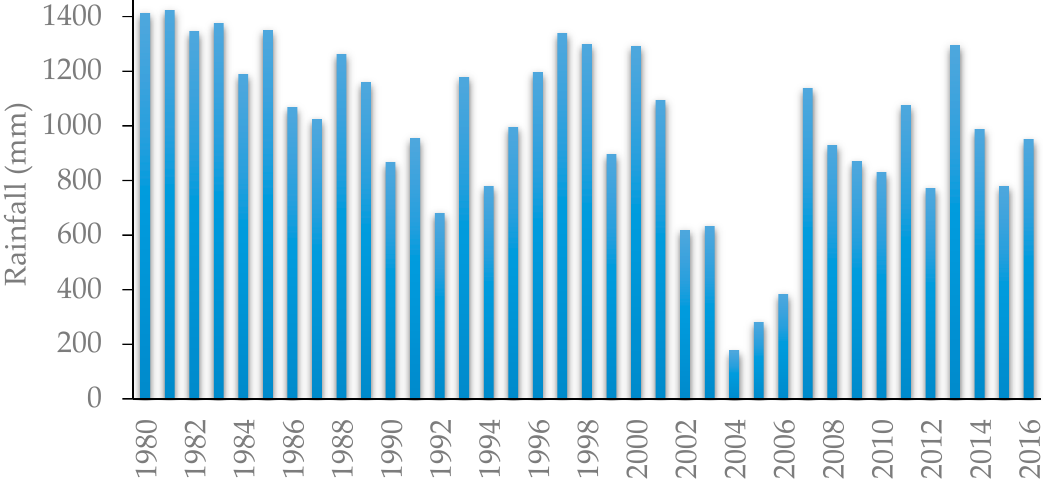
Figure 2. Variation in rainfall over the years in the Sarada river basin, Nepal .